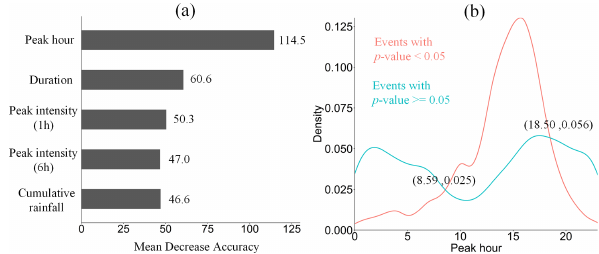
Figure 4. (a) The importance of the five rainfall indicators obtained by the random forest model. The peak hour is the most important covariate that triggers human activity anomalies and has the high- est decrease accuracy value of 114.5. (b) The peak hour thresholds identified from the differences in the peak hour PDF values between the rainfall events with and without significant collective human activity anomalies. When the peak hours are between 08:59 and 18:50UTC + 8, the PDF values of the events with human activity anomalies are higher than those without. In other words, daytime rains are more likely to trigger human activity anomalies. There are 11491 daytime rains (i.e. from 08:59 to 18:50UTC + 8) out of the total 20860 rainfall events (ratio: